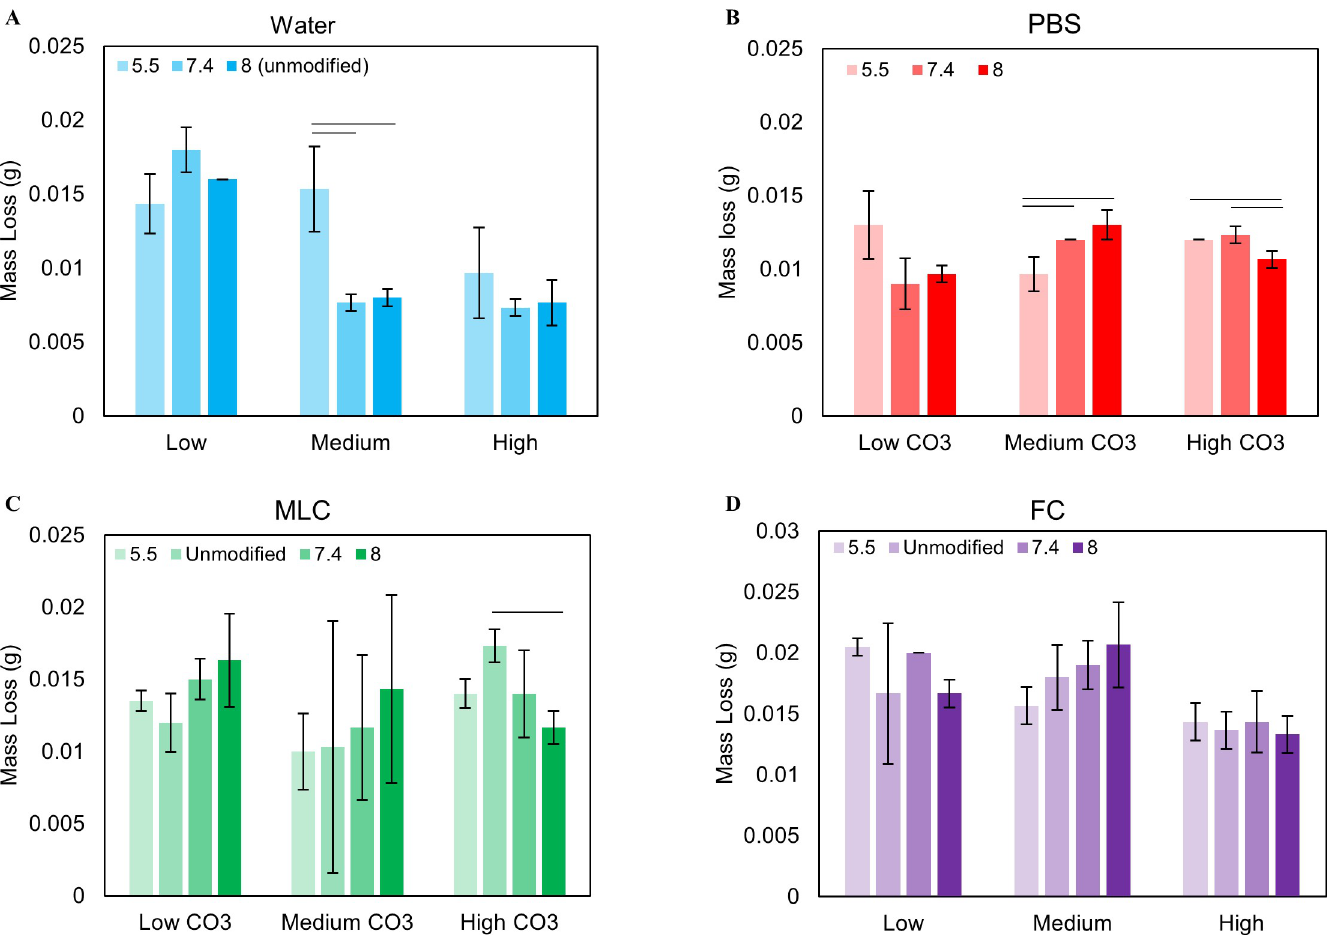
Fig 4. Mass loss as a function of pH at each wt% carbonate for each solution. Mass decreased for all solutions, indicating powder erosion (A-D) . Powders in FC had the greatest mass loss (D) while PBS and Water had the least (A, B) .